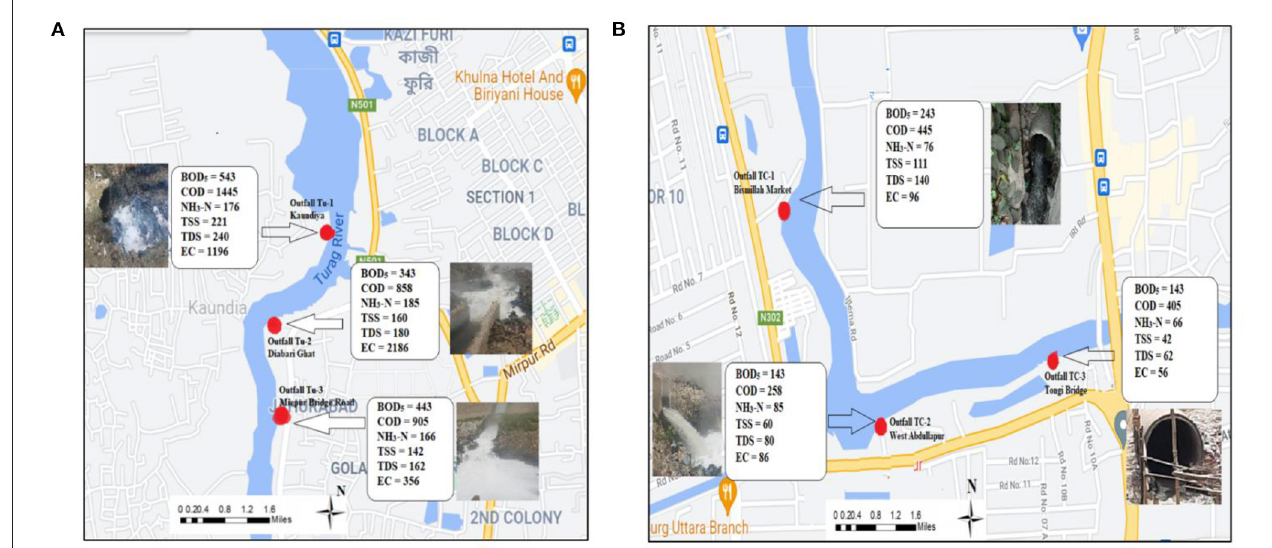
FIGURE 11 | (A,B) Waste load contribution in Turag River and Tongi